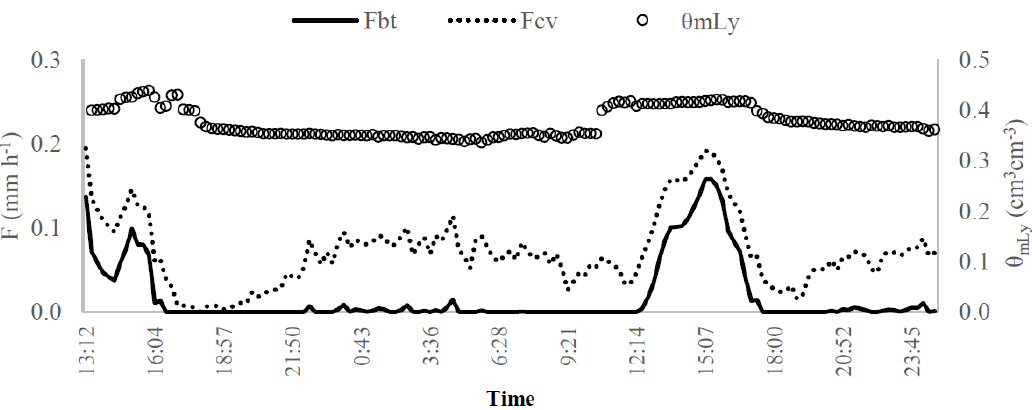
Figure 12. Circadian curve for days 14–15 October 2016 of soil moisture estimated with the mLy sensor ( θ mLy , cm 3 cm − 3 —empty circle: right vertical axis) and the transpiration (F, mm h − 1 —left vertical axis) estimates based on the sap flow conventional (dash line) and Biot-Granier (full line) approaches (Experiment III).